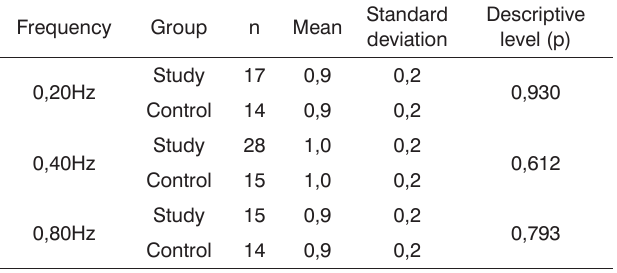
p≤0,05 Table 5. Comparing the optokinetic nystagmus slow component angular velocity between the groups: